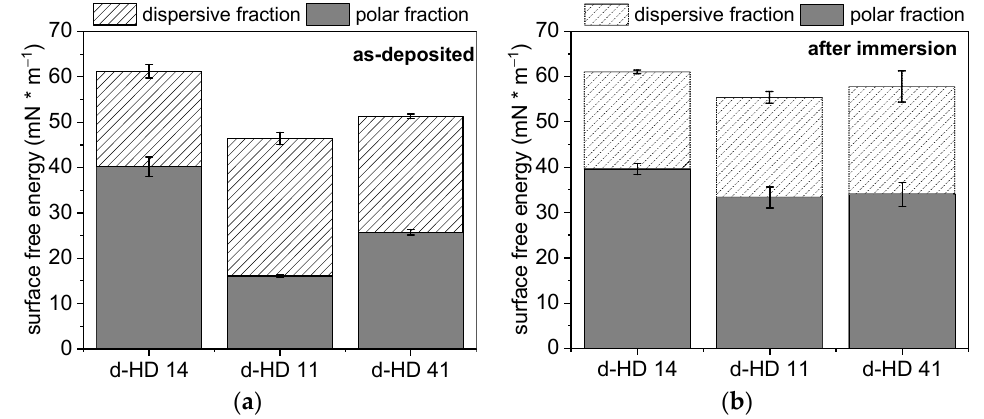
Figure 5. Surface free energy of the hydrogel mixtures generated using the droplet method ( a ) as- deposited and ( b ) after immersion in water for 24 h, divided into dispersive and polar fraction.